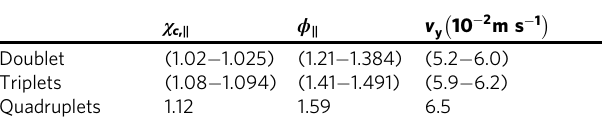
Particle parameters and the resulting v y for doublets, triangular triplets, and tetrahedral quadruplets oriented parallel to the fl ow 46 – 50